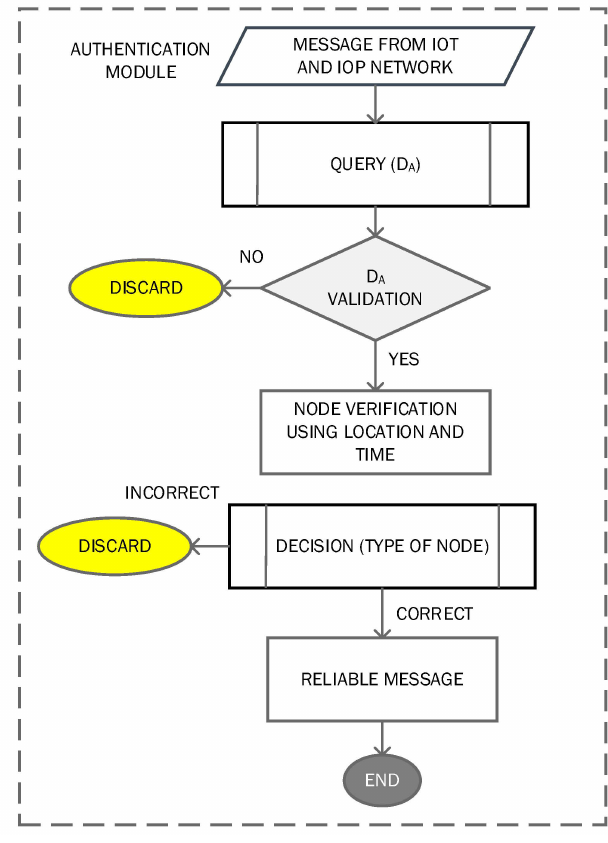
Figure 3. Authentication module